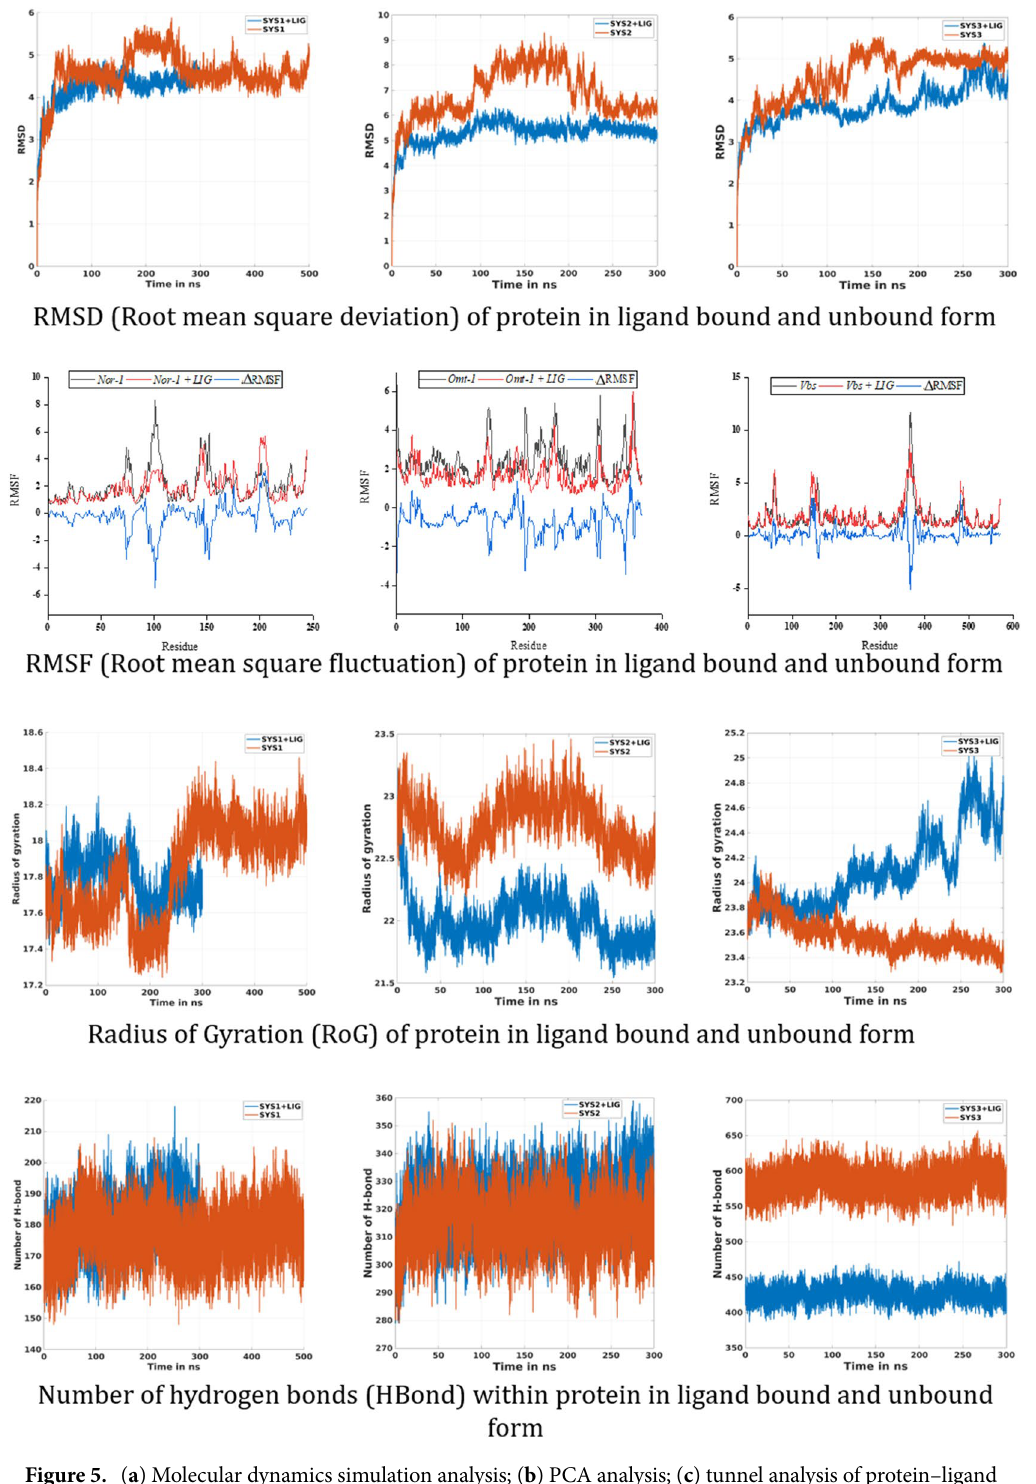
Figure 5. ( a ) Molecular dynamics simulation analysis; ( b ) PCA analysis; ( c ) tunnel analysis of protein–ligand